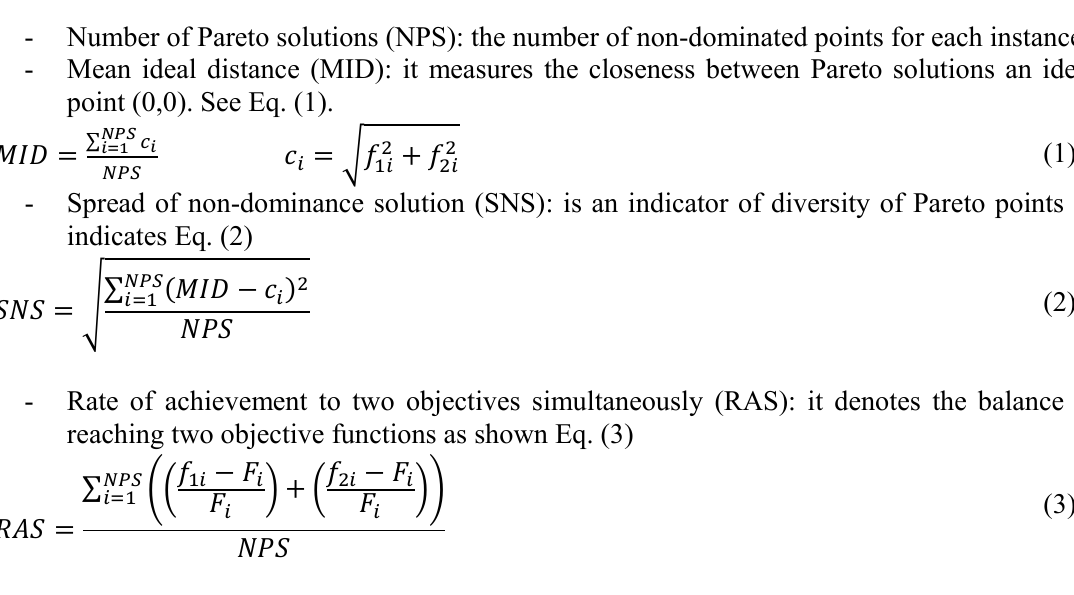
Number of Pareto solutions (NPS): the number of non-dominated points for each instance Mean ideal distance (MID): it measures the closeness between Pareto solutions an ideal point (0,0). See Eq.